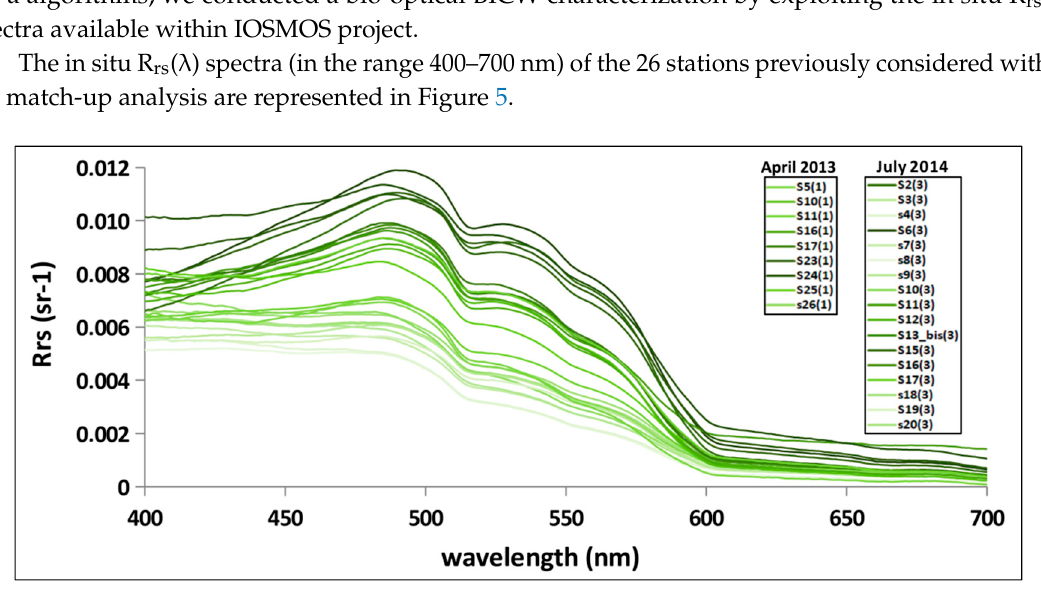
Figure 5. In situ R rs ( λ ) spectra acquired on 26 IOSMOS stations. Within the legend, two numbers characterize each spectrum: the first is the identification of the stations and the second (in parentheses) relates to the measurement campaigns (from 1 to 3).